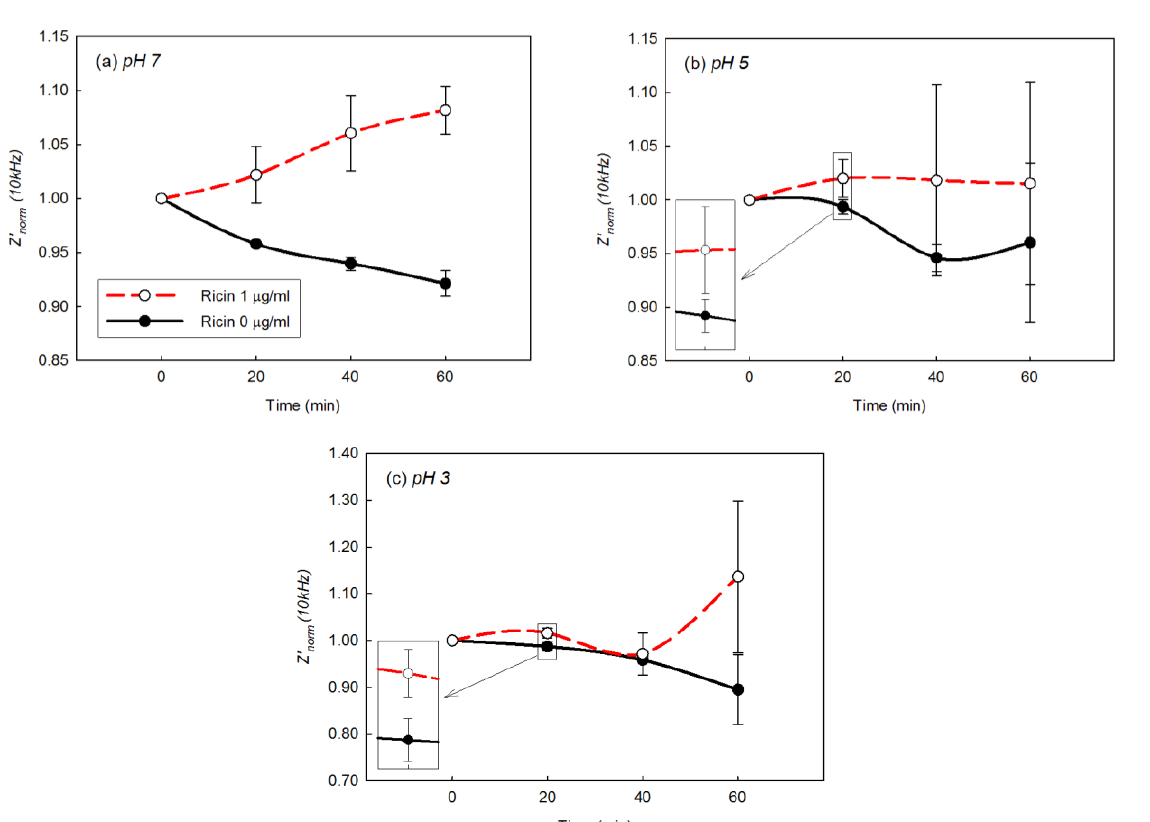
Figure 7. Z’ (10 kHz) from EIS analysis of EII in 0 μg/mL and 1 μg/mL of Ag at norm (a) pH 7, (b) pH 5, and (c) pH 3. Ricin, the biological toxin, was used as the Ag of